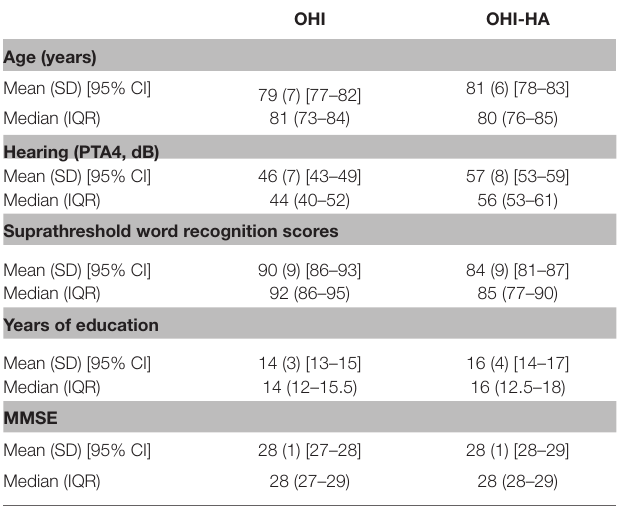
TABLE 1 | Age, hearing, word recognition, education, and cognitive screening. OHI